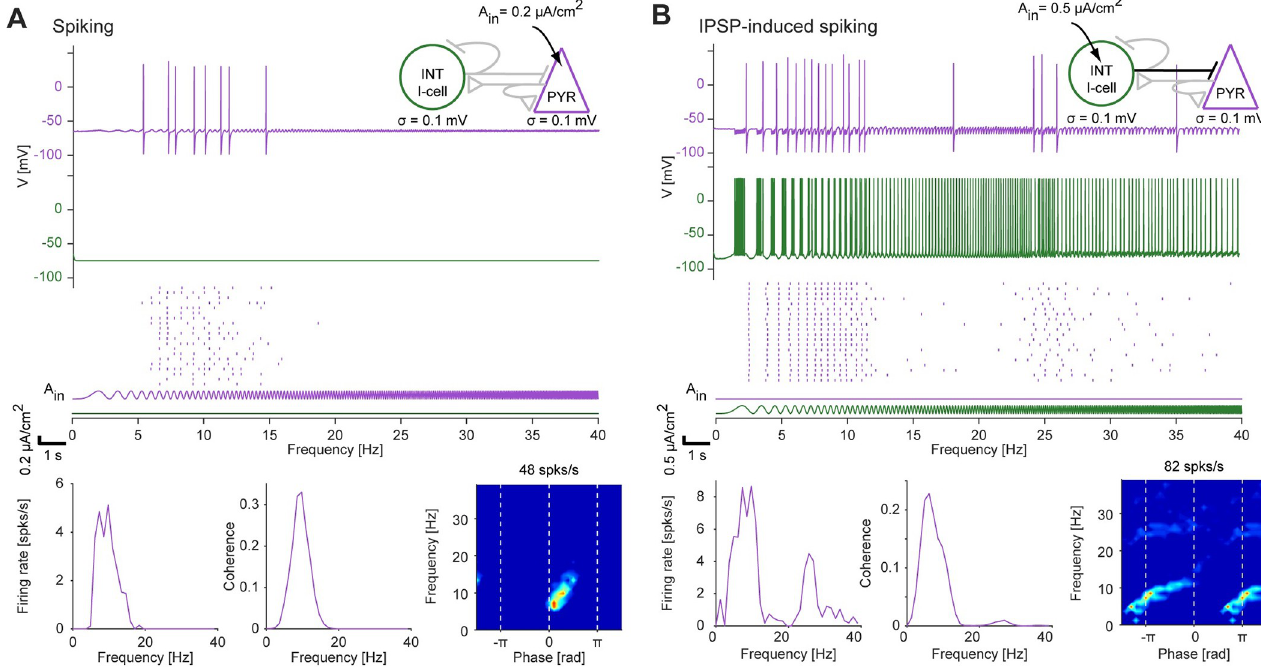
Fig 7. Inhibition-induced network resonance can be inherited from the level of membrane potential fluctuations. ( A ) A PYR model neuron, with h- current and full spiking dynamics, was driven by a constant-amplitude periodic current in the form of a linear chirp (0–40 Hz, 20 s; A ine = 0 . 2 μA/cm 2 ). Top : Membrane potential response during a single trial. Center : Raster plots from 20 independent trials. Bottom : Quantification of spiking resonance. As in the simpler model ( Fig 2 ), the LPF and HPF correspond to RC (membrane capacitance and leak current) and the h-current, respectively. PYR spikes are generated around the peak of the input cycles in a narrow frequency band around 10 Hz, exhibiting spiking resonance. ( B ) The PYR model neuron of panel A was connected via an inhibitory (GABA A -like) synapse to a presynaptic I-cell (INT). Only the INT was driven by a constant amplitude periodic current ( A 0 . 5 μA/cm 2 ). Other possible synaptic connections were kept at zero (light grey lines in the cartoon, top right ), isolating the contribution of feedforward inhibition. The PYR spikes after a series of INT spikes, around the trough of the input cycles given to the INT. The narrow-band PYR spiking exhibits IPSP- induced (network) resonance. All conventions are the same as in panel A